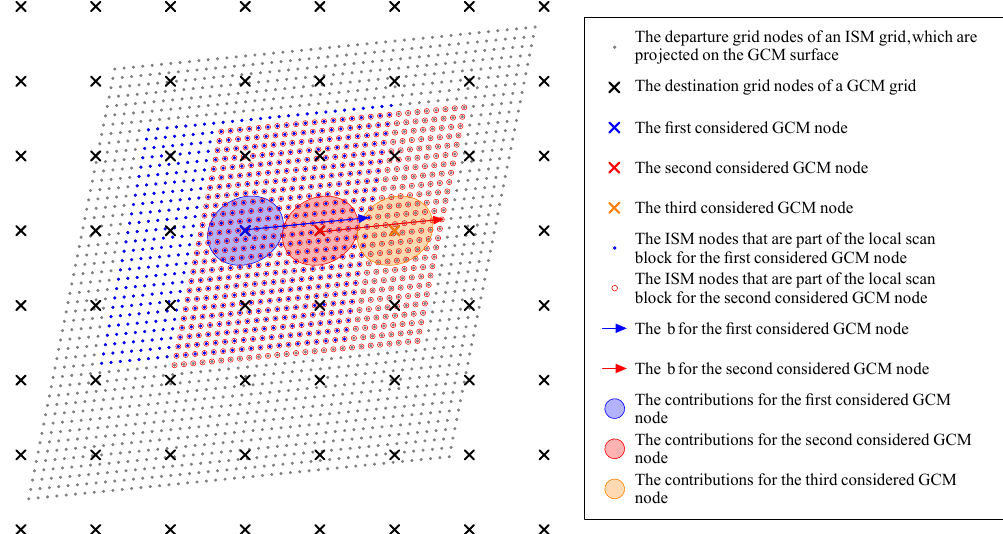
Figure 4. Situation sketch of the procedure to find the next scan block for an ISM–GCM mapping, in the case that the radius interpolation method is used. Consider the situation for which the contributions (the ISM nodes in the blue shaded circle) are found for the first considered GCM node ( ). In order to find the contributions for the second considered GCM node ( ), a scan over a local block is conducted. This local block is constructed by taking the nearest contribution (the pivot) and extending the block in all directions by b (indicated by the arrows in the figure). In this case the pivot is the ISM node under the marker and the marked block is extended as indicated by the blue arrow. The contributions for the second considered GCM node lay in the red shaded circle. The pivot shifts to the GCM node under the marker. The scan for the third considered GCM node ( ) is conducted over the marked ISM nodes in order to find the orange shaded contributions. Thereafter the pivot shifts again to the ISM node under the marker for the next